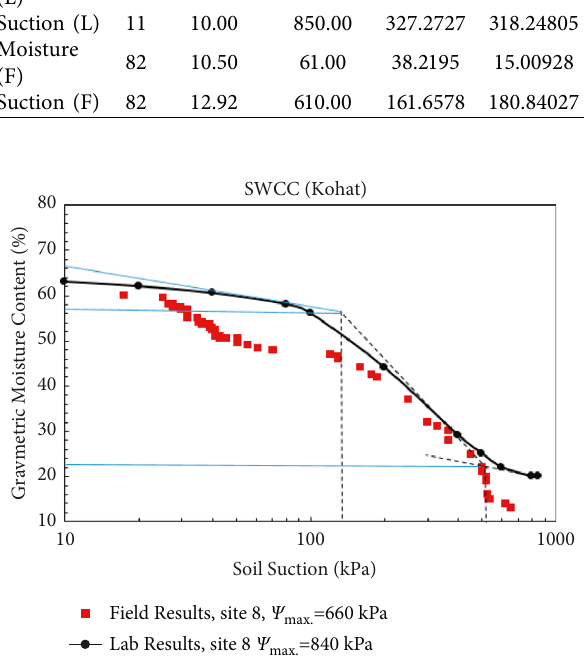
Figure 7: Demonstration of field- and lab-based SWCCs for Karak expansive soil.